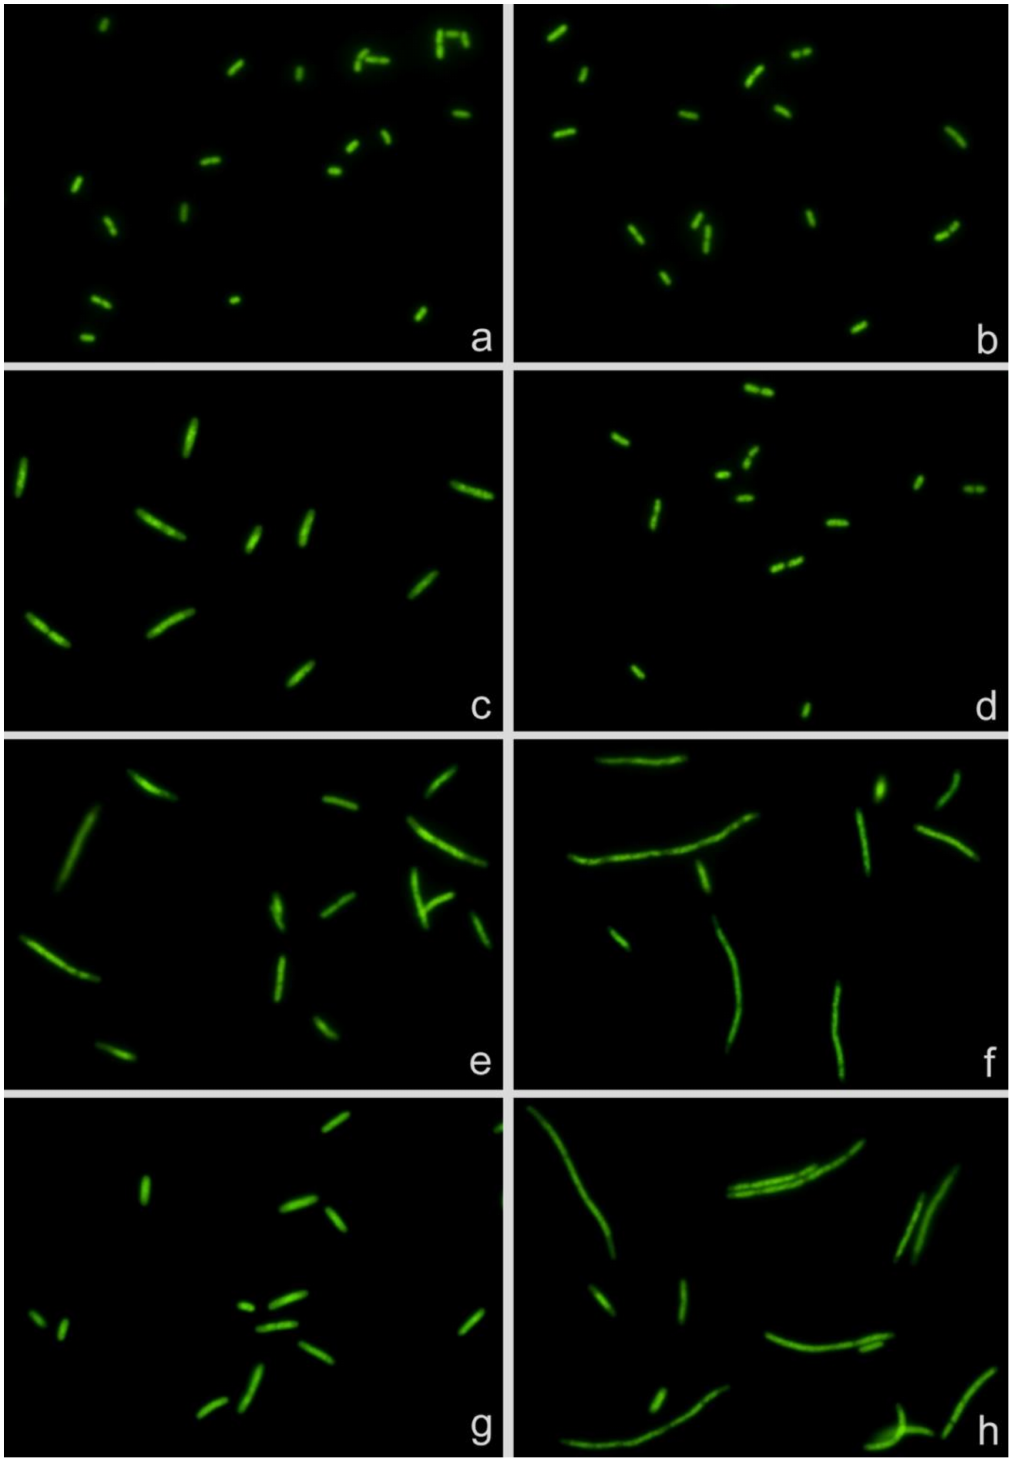
Figure 1. Escherichia coli strains susceptible (left, MIC: 0.125 mg/L) and resistant (right, MIC: >32 mg/L) to cotrimoxazole. ( a , b ) Control without antibiotic. ( c , d ) Incubated with cotrimoxazole, 2 mg/L. ( e , f ) Treated with mitomycin C (MMC), 0.5 mg/L. ( g , h ) Incubated with cotrimoxazole and MMC. MMC induces cell elongation in both strains ( e , f ). Cotrimoxazole induces cell lengthening and prevents MMC-induced cell enlargement in the susceptible strain ( c , g ) but not in the resistant strain ( d , h